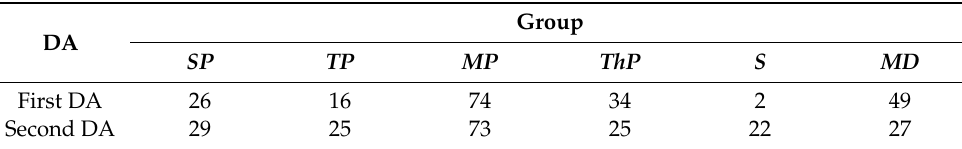
Table 5. The number of plots for each discriminant analysis for each group ( SP : Seedling Poles; TP : Thin Poles; MP : Medium Poles; Th : Thick Poles; S : Stratified; MD : Multi-diameter).